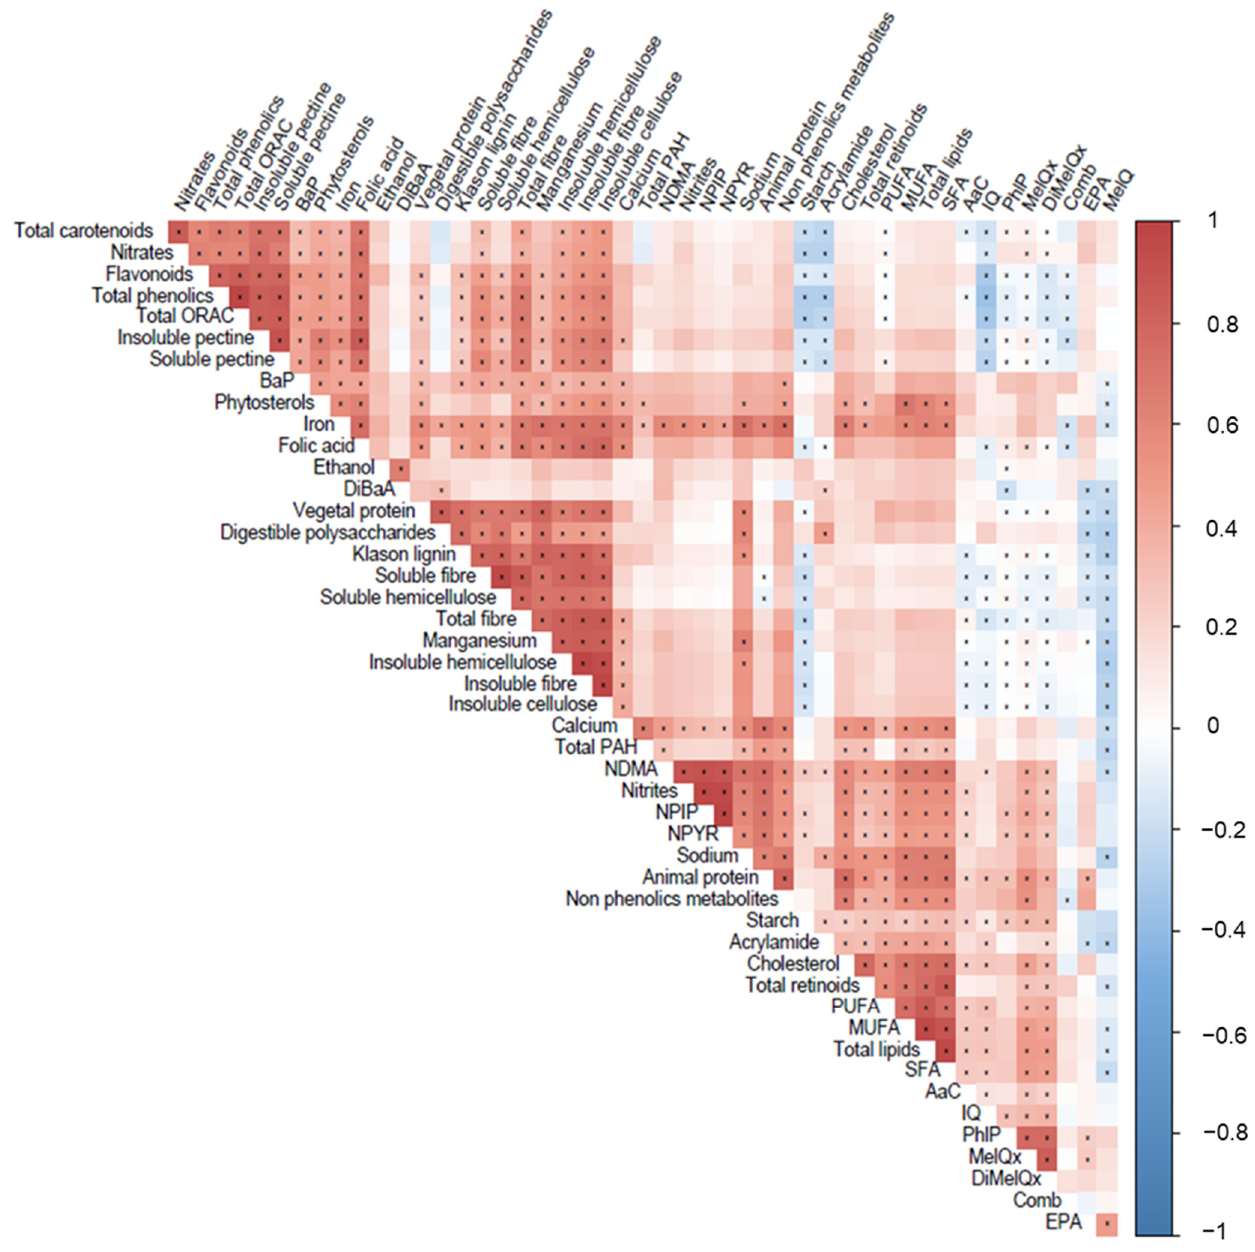
Figure 3. Graphical representation of correlations found between xenobiotic intake and other com- ponents derived from the diet. Only components showing significant correlations are represented.